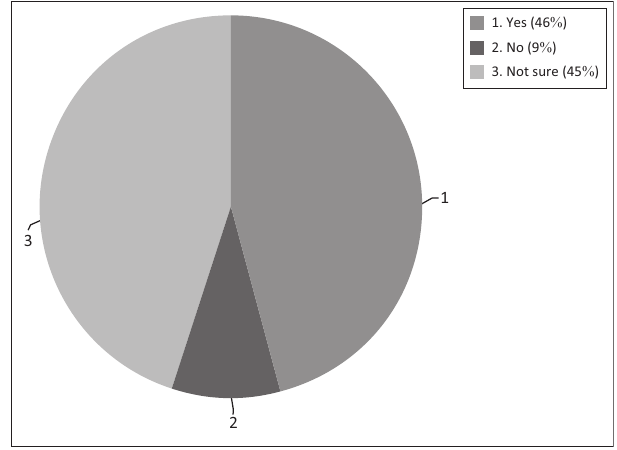
FIGURE 5: Bank supervision skills in the country of